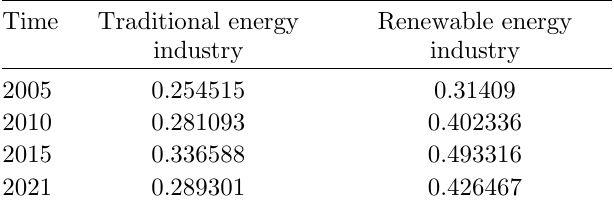
Table 2. Moran ’ s I of the energy industry in Hebei